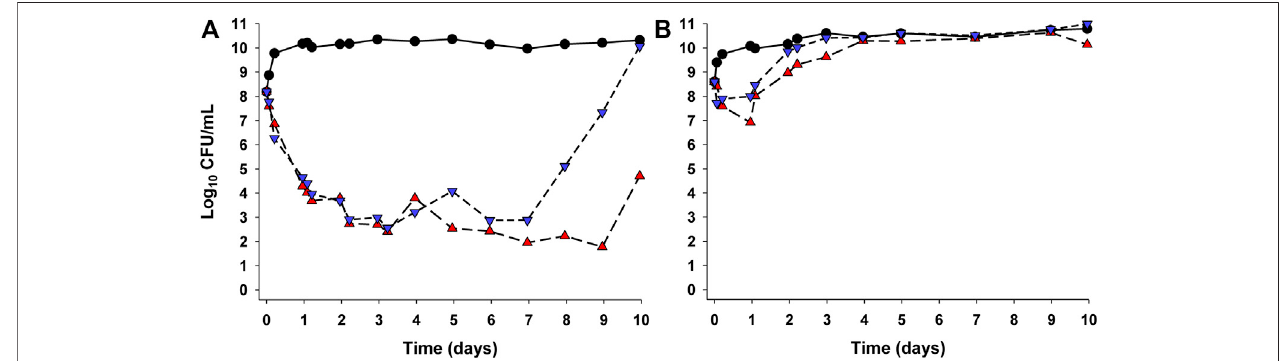
FIGURE 3 | Bacterial counts (CFU/mL) of Pseudomonas aeruginosa wild-type reference strain PAO1 which is non-hypermutable (A) and its PAO Δ mutS isogenic hypermutable strain (B) in the hollow- fi bre in vitro infection model over 10 days (Landersdorfer et al., 2018). Each strain had a meropenem MIC of 1 mg/L and each was exposed to two meropenem dosing regimens (3 g/day as a continuous infusion [red triangles] generating exposure of 100% f T > 5 × MIC and 1 g as 30 min intravenous infusion every 8 h [inverted blue triangles] generating exposure of 36% f T > 5 × MIC ). The respective growth controls are shown as black circles. The fi gure is adapted from Figure 4 in the original publication of Landersdorfer et al.,